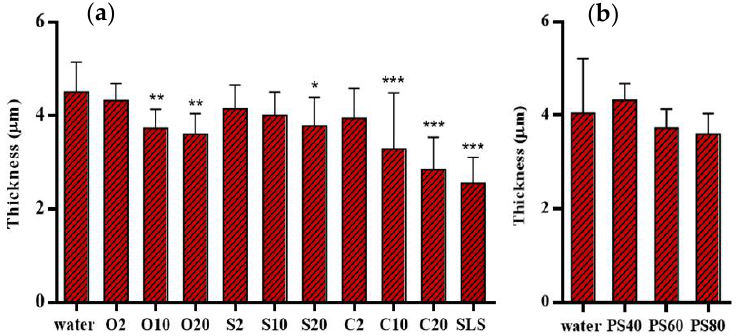
Figure 6. Thickness of SC after treatment with ( a ) PEG alkyl ethers treated SC and ( b ) PEG sorbitan esters treated SC. Mean ± SD, n = 18. * p < 0.05; ** p < 0.01; *** p < 0.001.